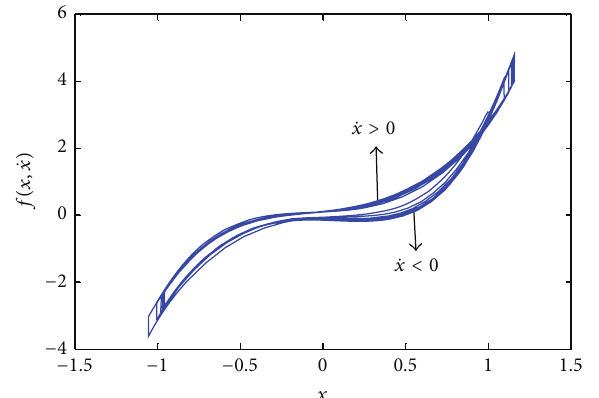
Figure 2: Asymmetric hysteresis force.